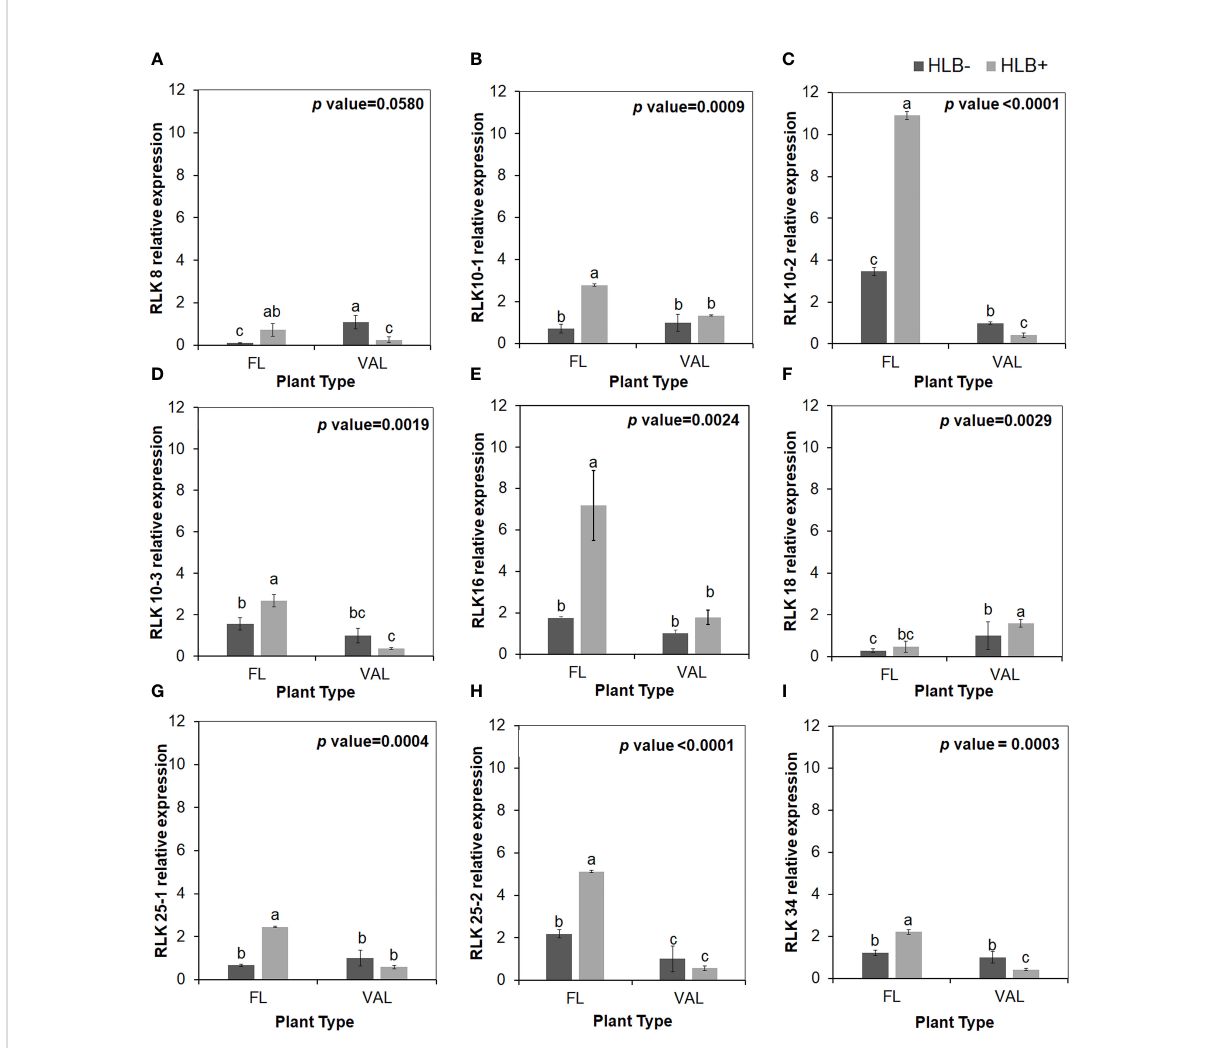
FIGURE 3 Relative transcript levels of cysteine-rich RLK (RECEPTOR-like protein kinase) as calculated by real-time PCR compared with the CaLas free ‘ Valencia ’ . The CaLas infected samples were collected from fi ve year old trees growing in the fi eld and the CaLas free (control) samples were collected from trees growing in a protected greenhouse. (A – I) Relative RLK expression as detected in this study compared with CaLas free 'Valencia'. The control trees were con fi rmed negative for CaLas before further comparison. Data are means±SE of twelve samples. Different letters above the error bar indicate statistically signi fi cant differences, while the same letters signify no signi fi cant differences using the Tukey – Kramer honestly signi fi cant difference test (Tukey HSD; p